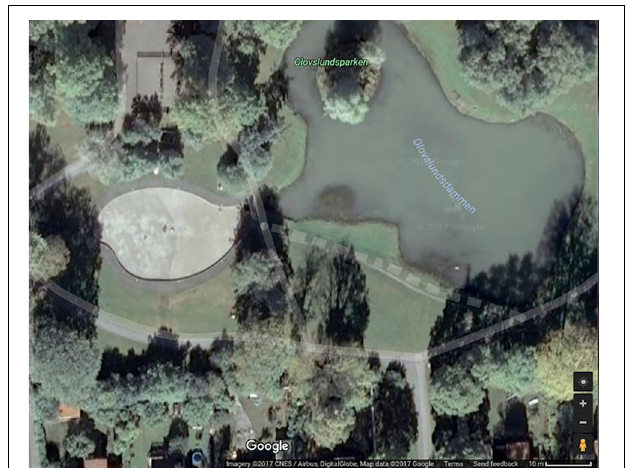
FIGURE 2 | Olovslund Park with the pond on the right and the paddling pool to its left. The school is just a short walk away (source: Google